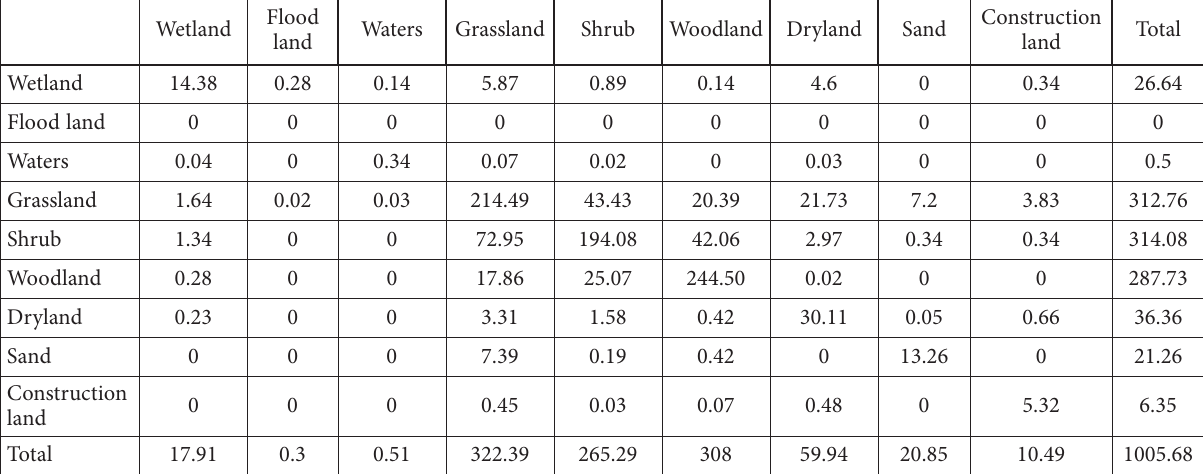
Table 3. Area transfer matrix of Saihanwula land use from 1985 to 2015 (km 2 )